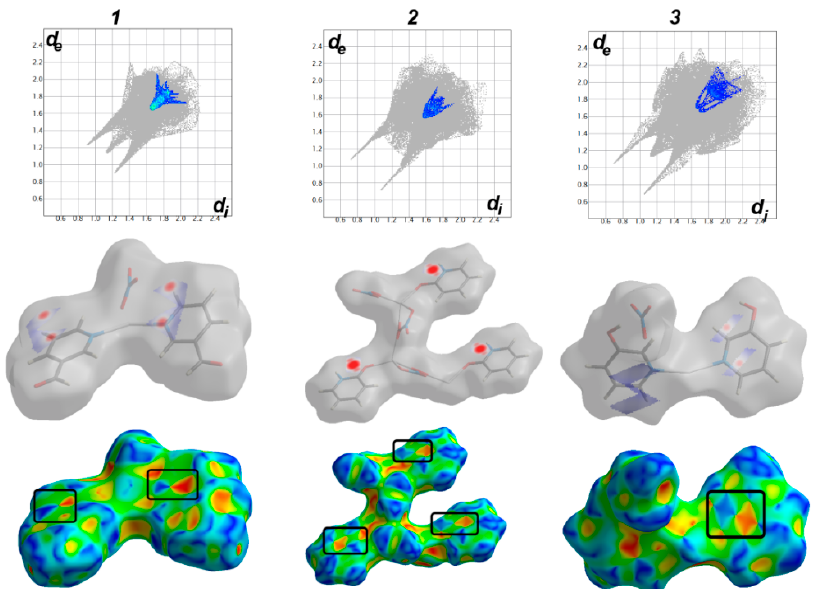
Figure 9. The fingerprint (upper), d norm maps (middle), and shape index (lower) of the C…C contacts.